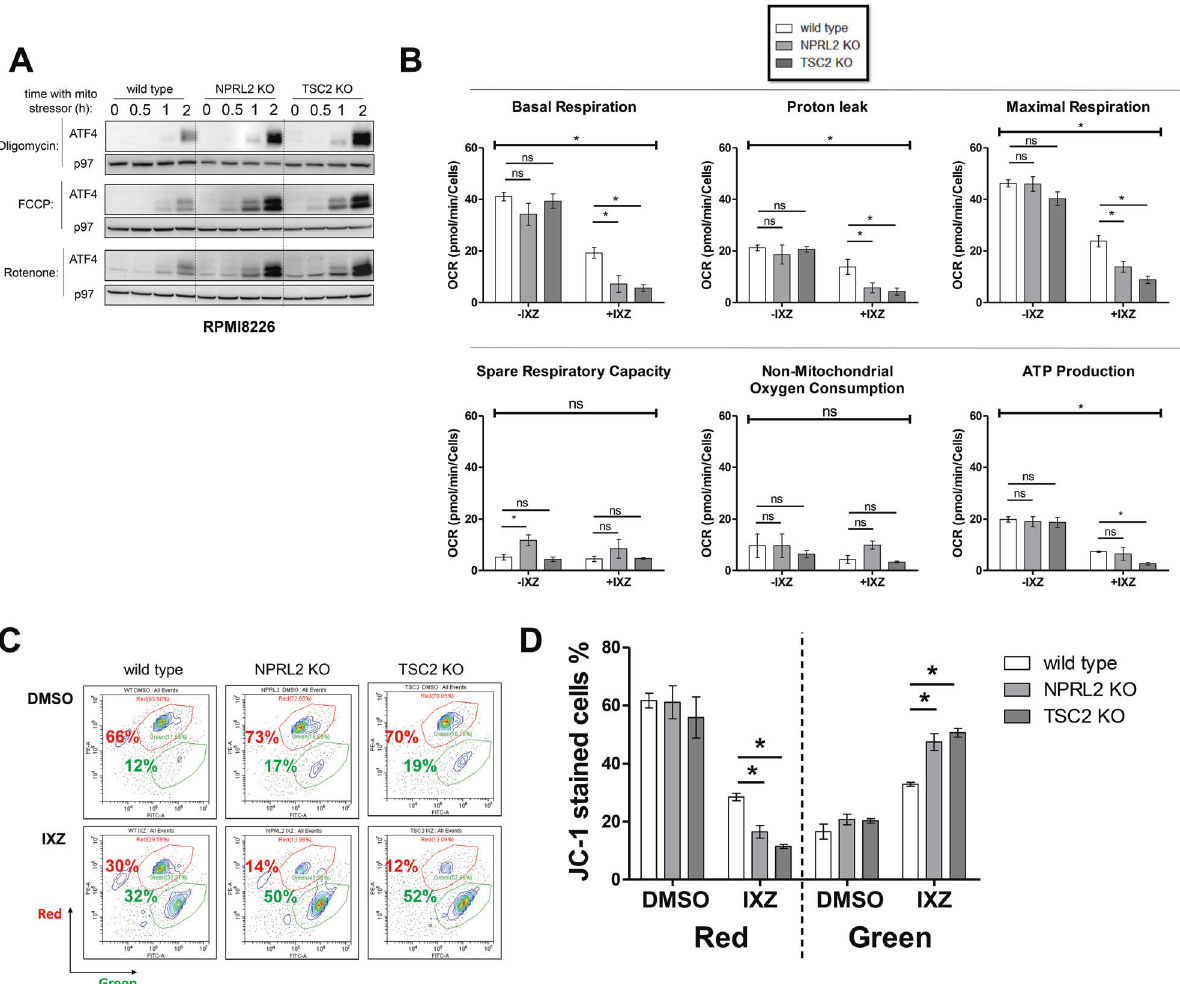
Fig. 4 mTORC1-activated MM cells generate a mitochondrial stress in response to mitotoxins and PIs. A ATF4 induction was monitored following oligomycin, FCCP and rotenone (each 1 µM) treatment in time-escalated manner as indicated. B Average OCR measurements are shown following treatment with either DMSO (-IXZ) or IXZ ( + IXZ) [20 nM for 16 h], error bars represent ±S.E.M., * p < 0.05 of unpaired two- tailed student ’ s t -test. ns, not signi fi cant. C Contour plots of JC-1 stained cells following treatment with either DMSO or IXZ [20 nM for 24 h] are shown and each represents a typical result out of three independent experiments. Red gate corresponds to cells with ‘ healthy ’ mitochondrial membrane potential and green gate corresponds to cells with ‘ unhealthy ’ mitochondrial membrane potential. D Column graph represents the average of three independent experiments described in ( C ), ±S.E.M., * p < 0.05 of unpaired two-tailed student ’ s t